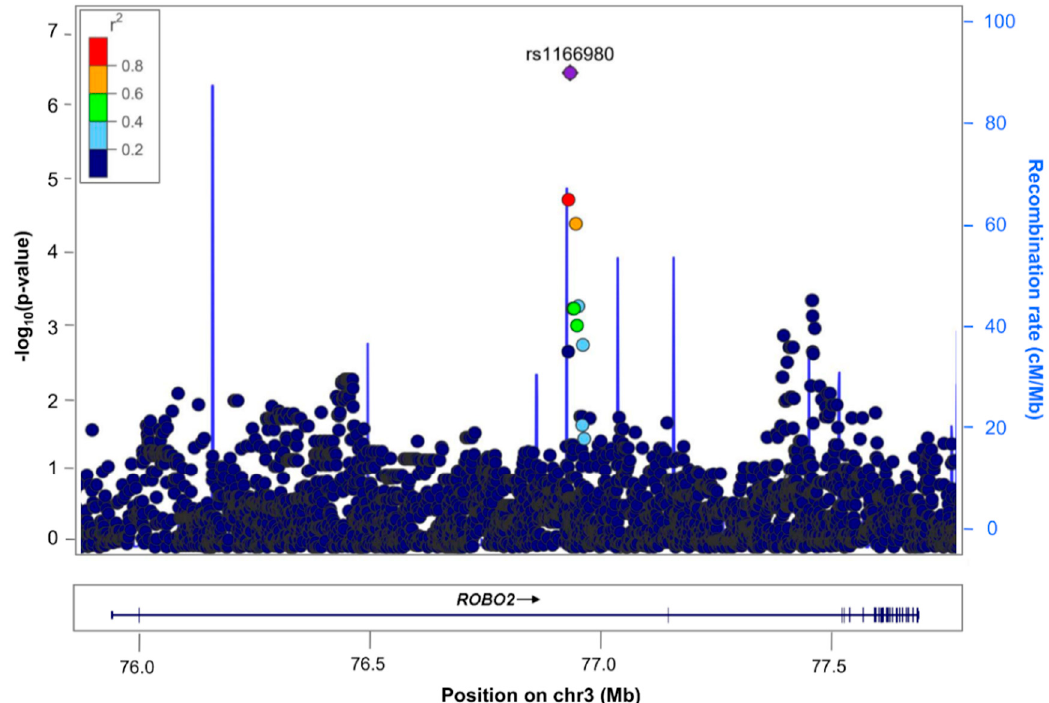
Figure 2. Regional plot of association results with the change in FEV 1 after ICS treatment expressed as a binary variable in SLOVENIA. Results are represented based on the significance of the association on the y -axis ( − log 10 p -value) and chromosome position ( x -axis) for each SNP as a dot. The SNP rs1166980 suggestively associated with ICS response is represented by the purple diamond. The remaining SNPs are color-coded based on pairwise linkage disequilibrium ( r 2 values) with that SNP for European populations from 1KGP (GRCh37/hg19 build).